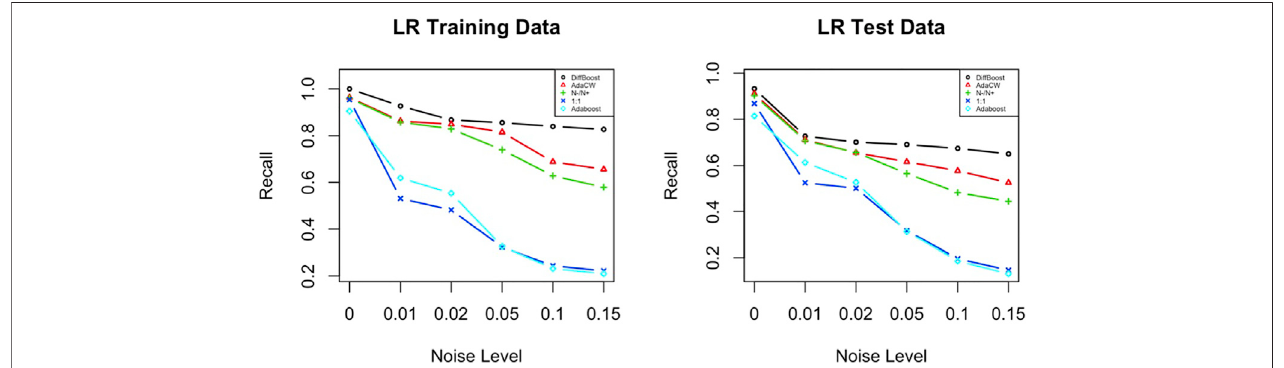
FIGURE 4 | Sensitivity to noise for both training data and testing data. Test is done on the IEEE 39-bus power system data. While all algorithms are impacted by noise, the proposed algorithms perform better.